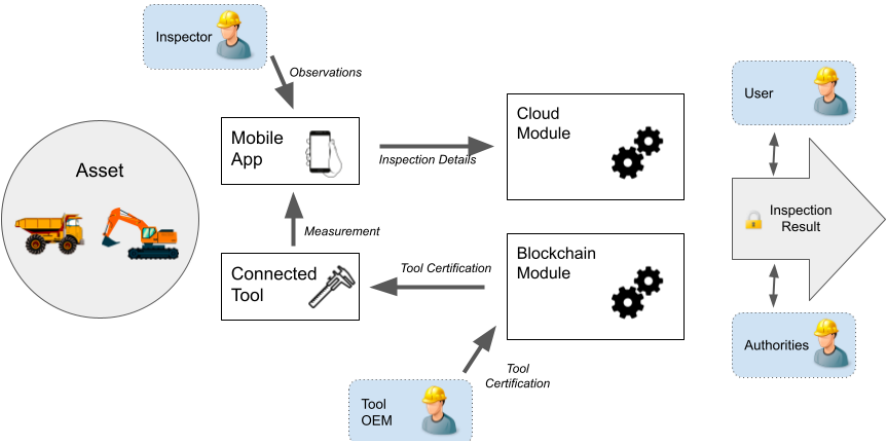
Figure 1. Proposed high-level architecture for a mining inspection